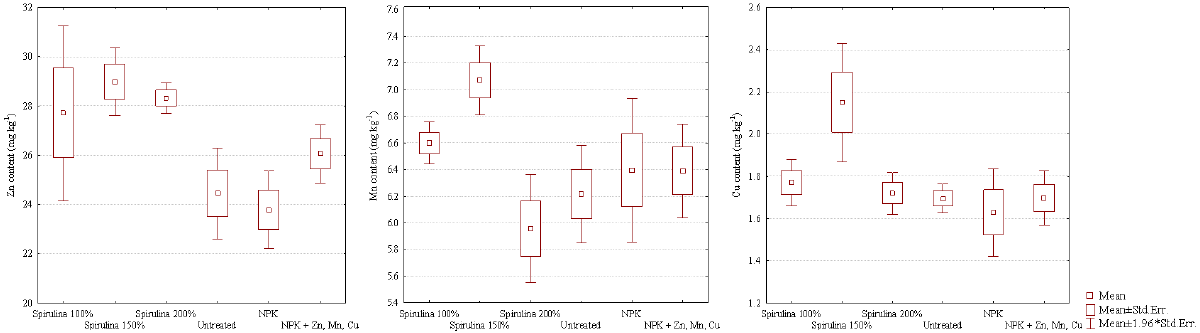
Figure 1: Zn(II), Mn(II), and Cu(II) content in grain in different